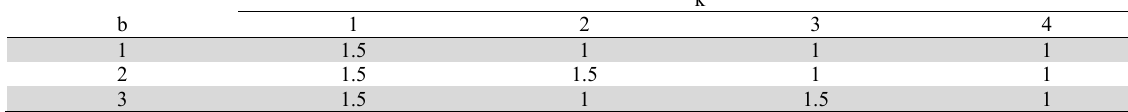
Maximum Capacity of Distribution Centers(CD b k ) (kg×10 3 )